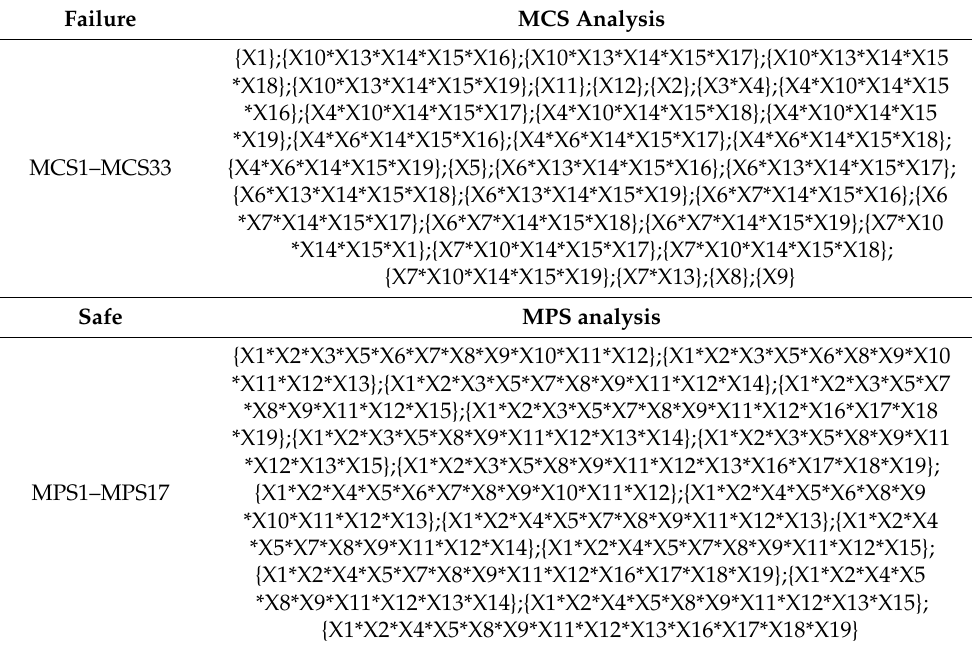
Table 6. Structural analysis under different states of the